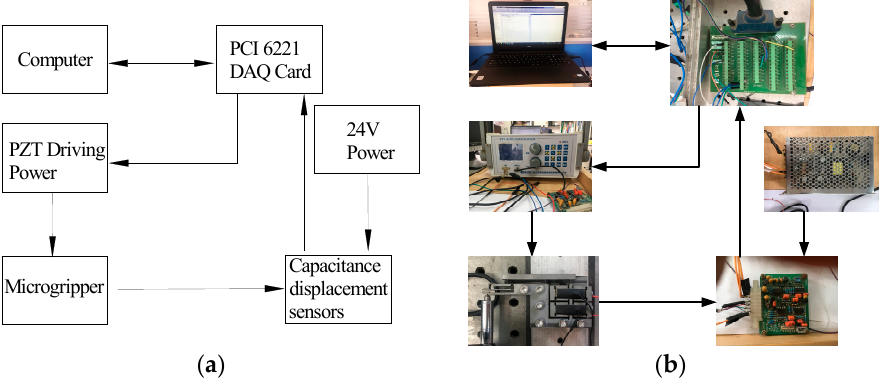
Figure 10. Working diagram of the experimental device. ( a ) functional block diagram and ( b ) actual working diagram.